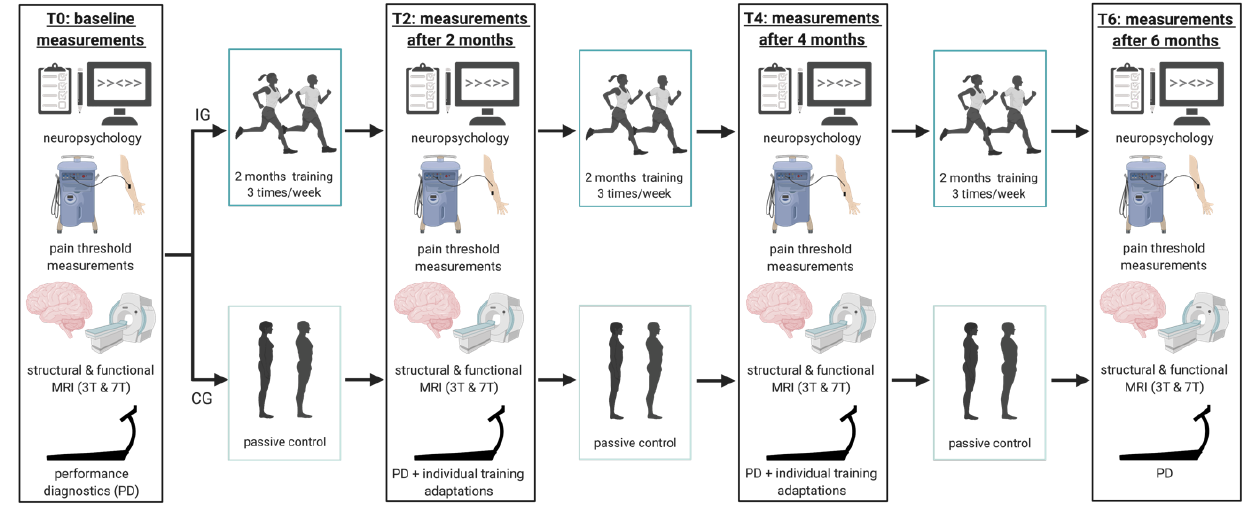
Figure 1. Study design. Figure created with Biorender.com.